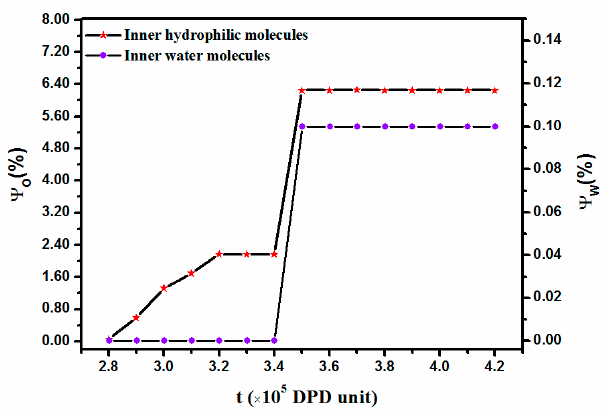
Figure 6. Diffusion number of solvophilic block O and solvent varies with time. φ O : number of interior solvophilic O-beads as percent of all solvophilic molecules of the structure ( left ); φ W : number of interior solvents as percent of all molecules of the structure ( right